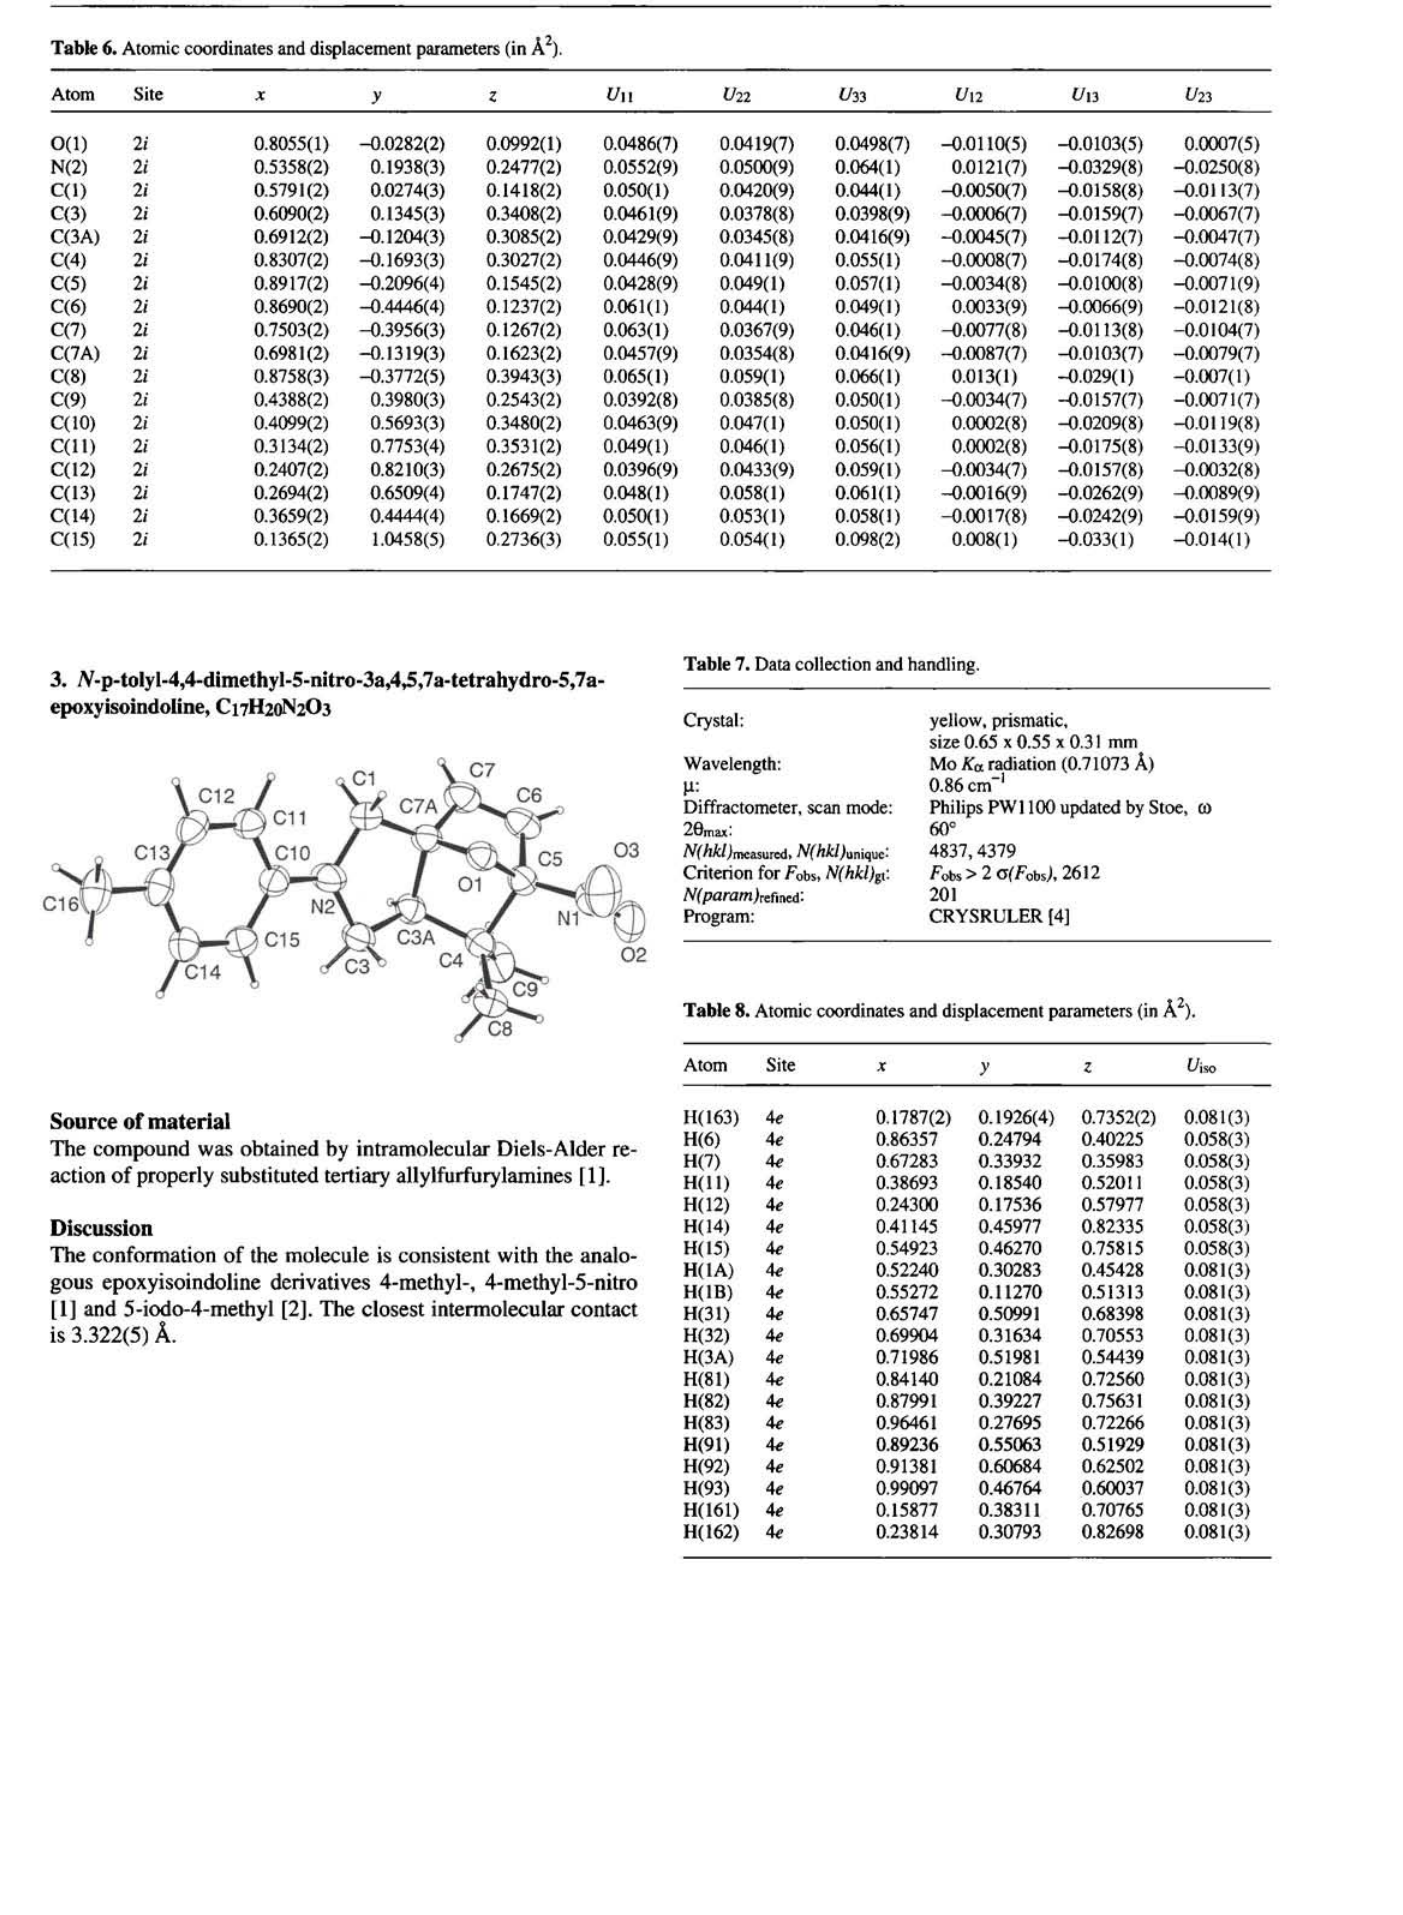
Table 7. Data collection and handling.